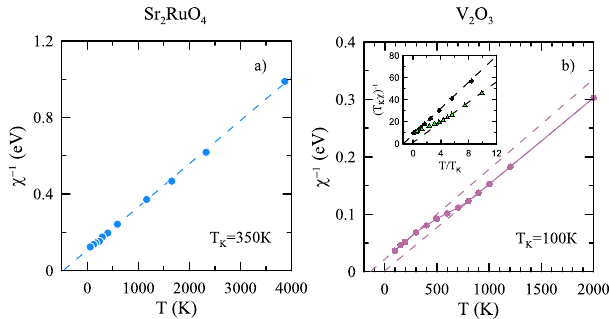
Fig. 1 Temperature dependences of inverse local susceptibilities χ − 1 ( T ). The inverse susceptibility, calculated from the data of ref. 1 for Sr 2 RuO 4 is shown on the plot ( a ) and that for V 2 O 3 is shown on the plot ( b ). The inset in ( b ) shows inverse spin susceptibility of the single-band half- fi lled Hubbard model on the square lattice with nearest-neighbor hopping t and on-site Coulomb repulsion U = 9 t (triangles) in comparison to the inverse spin susceptibility of the Kondo model 7 (circles); the Kondo temperature T = 0.032 t of the Hubbard model is extracted from the fi t of the low- K temperature part of the susceptibility to the Kondo model. Dashed lines show linear fi ts to the